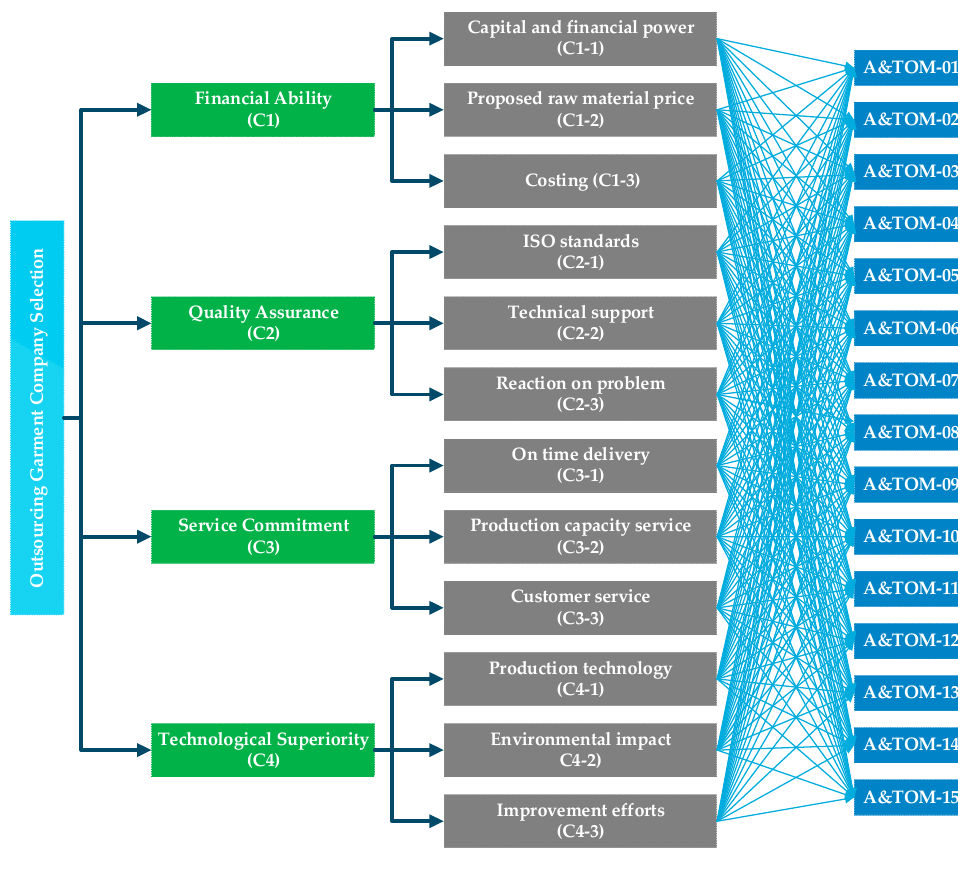
Figure 3. Criteria hierarchy.